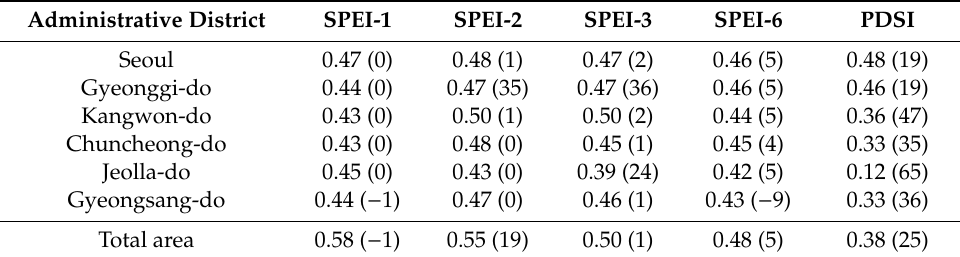
Table 3. Maximum cross-correlation (lag month) between SGI and other drought indices (SPEI and PDSI) during the study